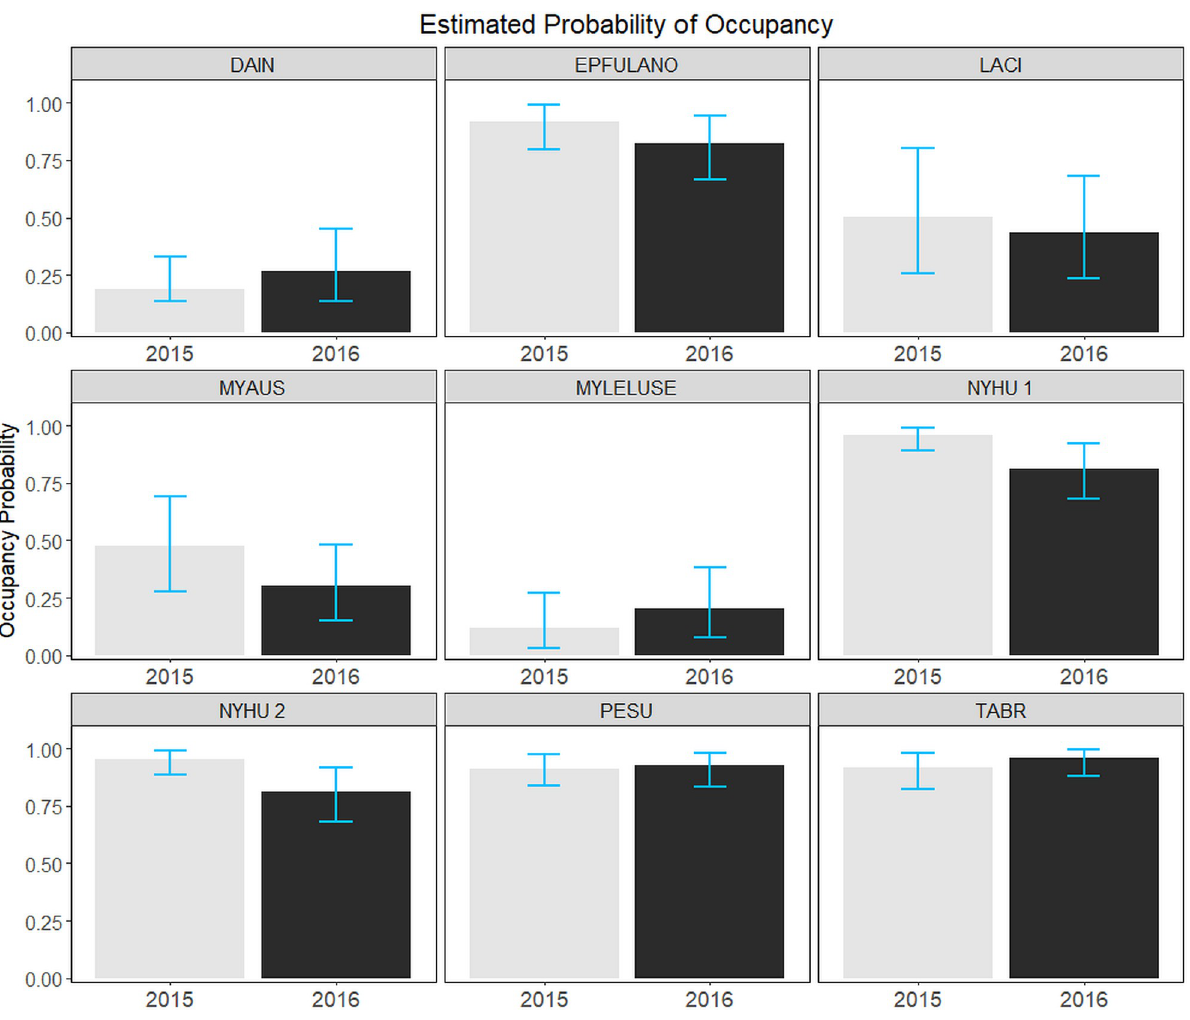
Fig 4. Estimated mean probabilities of occupancy of each species across South Carolina, May-July 2015 and 2016. Estimates are based on the top ranked occupancy model for each species. NYHU had two top-ranked models; NYHU 1 refers to the forest edge density (F.ED) model and NYHU 2 refers to the Stream + F.ED model. Blue bars indicate 95% credible intervals. Refer to Table 1 for species code definitions.